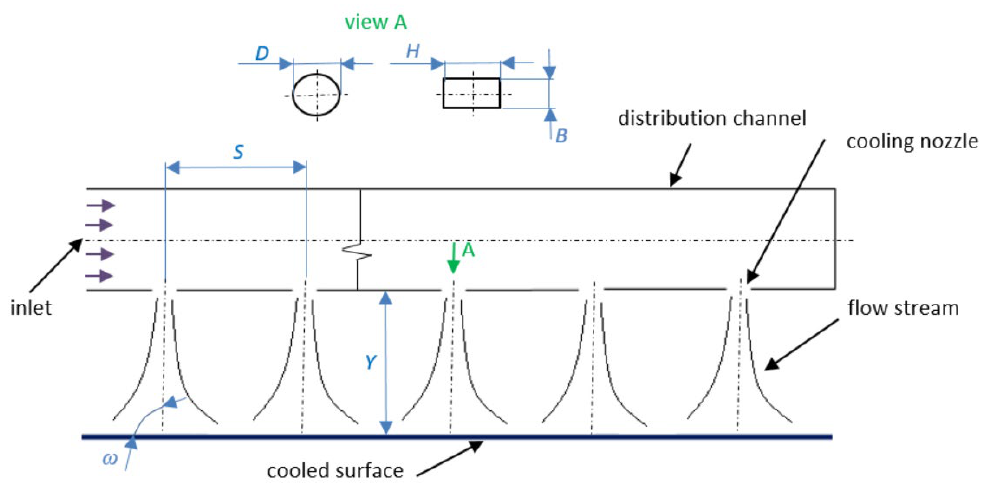
Figure 3. Impingement cooling systems distribution channel’s axis cross-section.